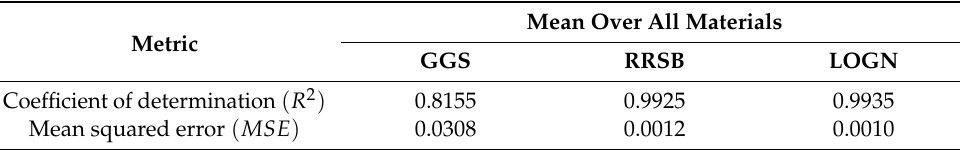
Table 1. Coefficient of determination and mean squared error of analytical distribution